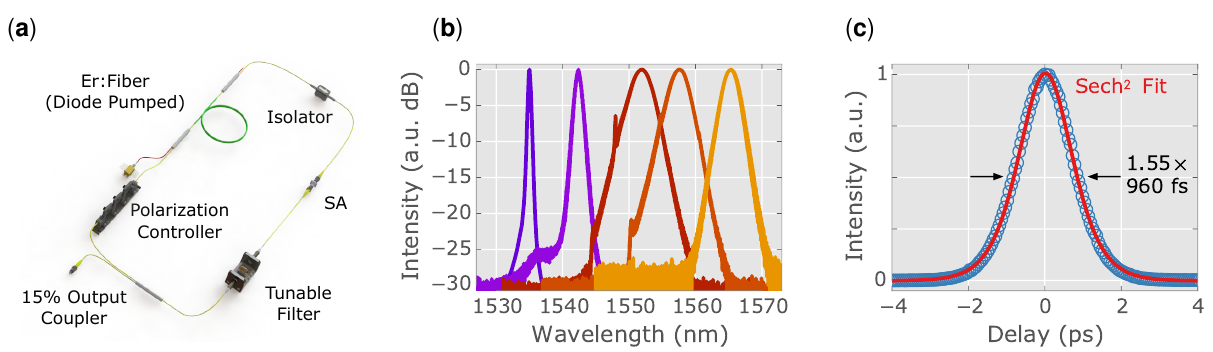
-PVA saturable absorber, 2